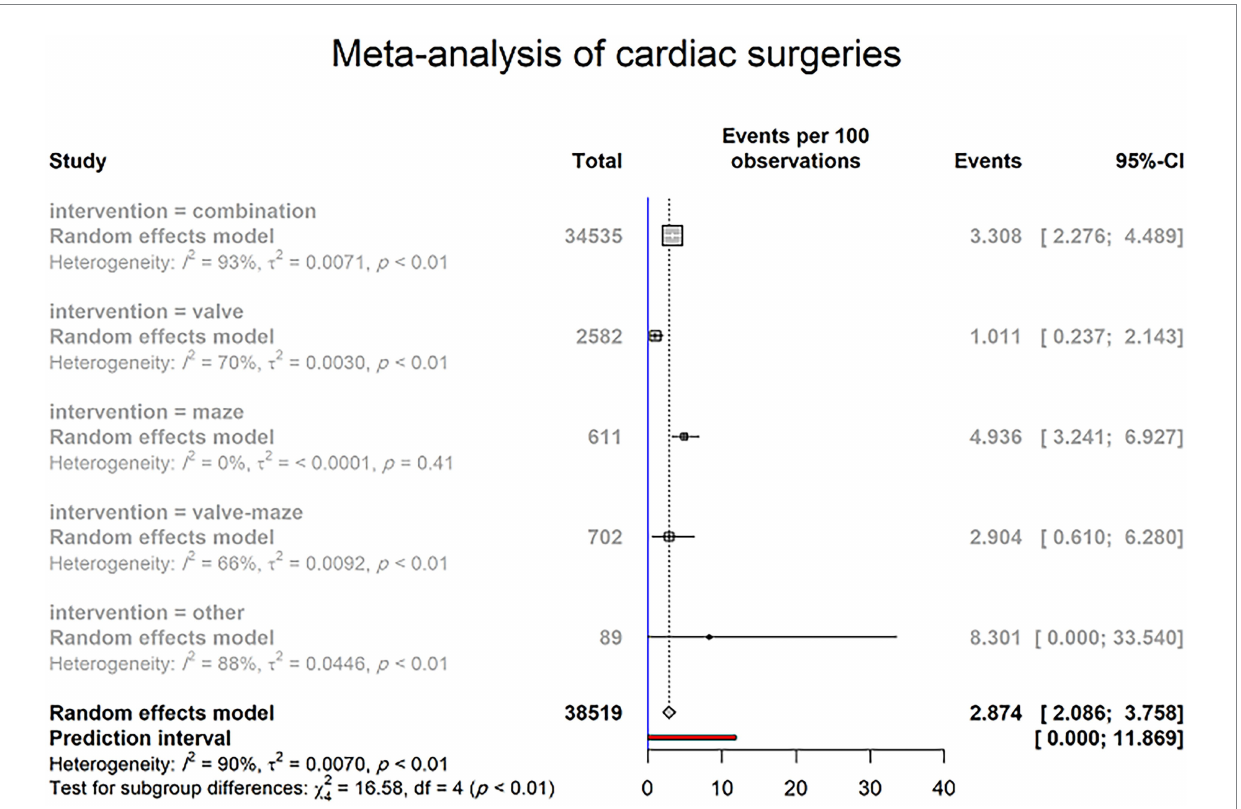
FIGURE 3 PPM implantation rate due to SND in patients undergoing cardiac surgeries (random effects model). The Events (percentages) in different intervention subgroups are represented by squares, through which the horizontal lines represent the 95% CIs. The diamond at the bottom represents the pooled intubation rate from these studies. The red bar in the bottom represents the prediction